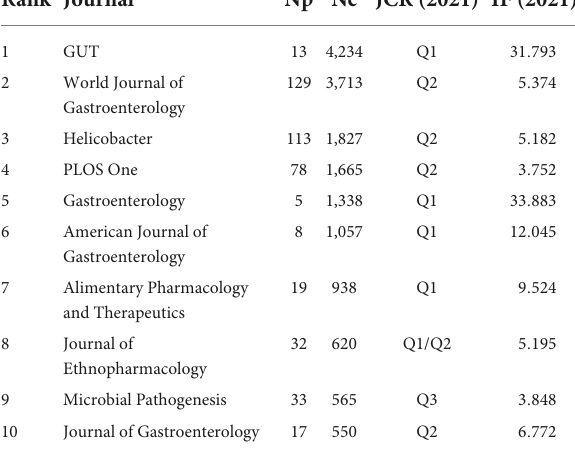
TABLE 4 Top 10 journals with the most citations in the field of Helicobacter pylori -related gastric ulcer